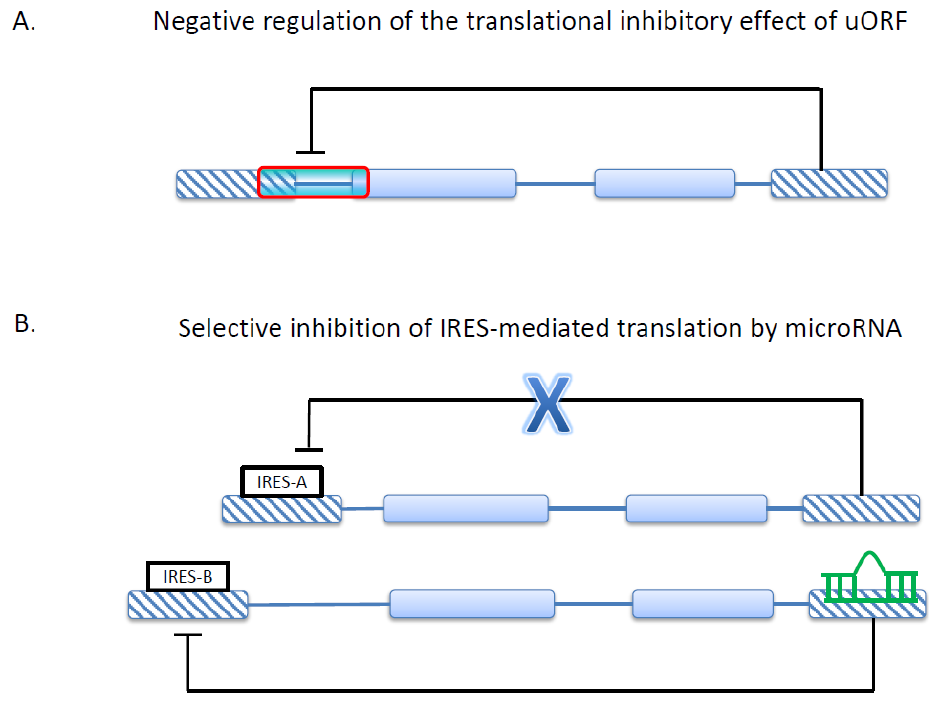
Figure 4. Two types of regulatory interactions between 5'UTR and 3'UTR. ( A ) 3'UTR can negatively regulate the translational inhibitory effect of the uORF in the same transcript; ( B ) By binding to 3'UTR, microRNAs can selectively regulate the activities of IRESs. Note that this illustration does not show the exact transcript structures of the genes (HER-2 or VEGF-A) mentioned in the